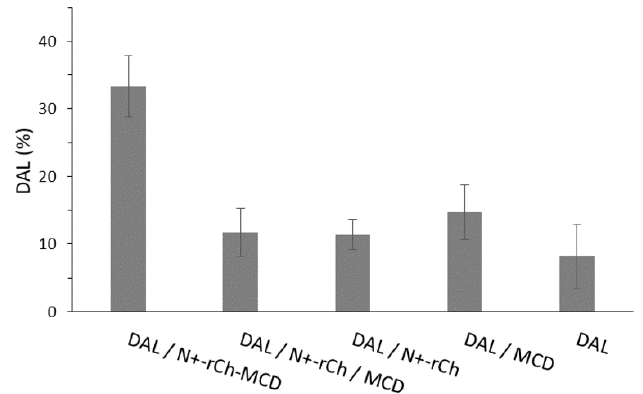
Figure 9. Percentage of DAL remaining in the apical chamber after 3 h of incubation on Caco-2 monolayers. Error bars indicate the SD values of three experiments.